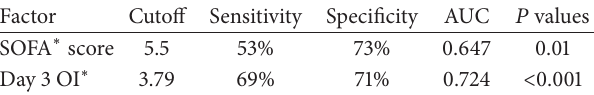
Table 6: Comparison of cutoff value, sensitivity, specificity, AUC ∗ , and P values between OI and physiological severity scores.